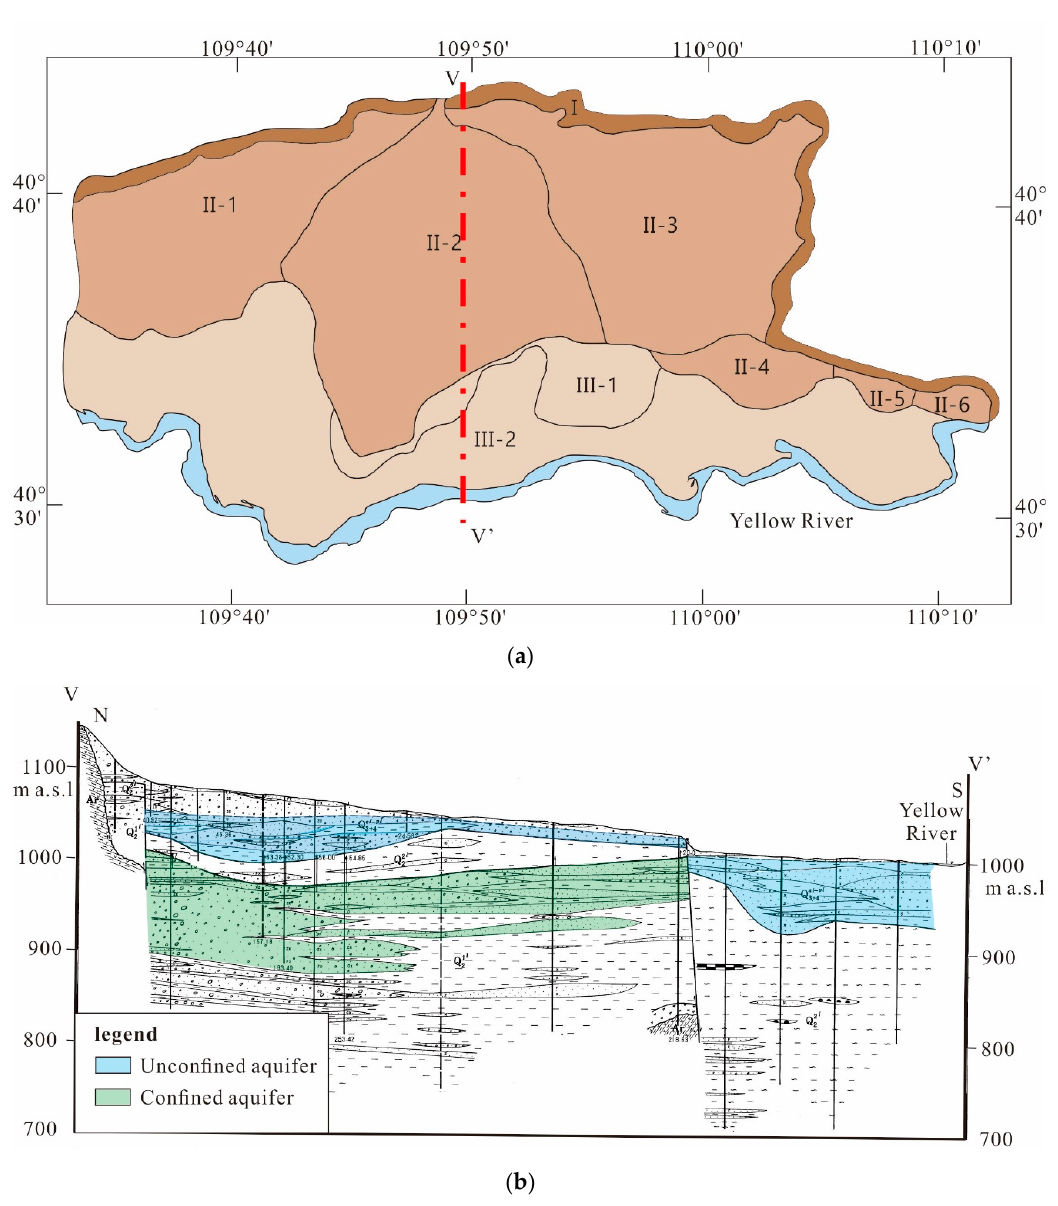
Figure 2. Hydrogeological area distribution ( a ), and hydrogeological profile of the study area ( b ).